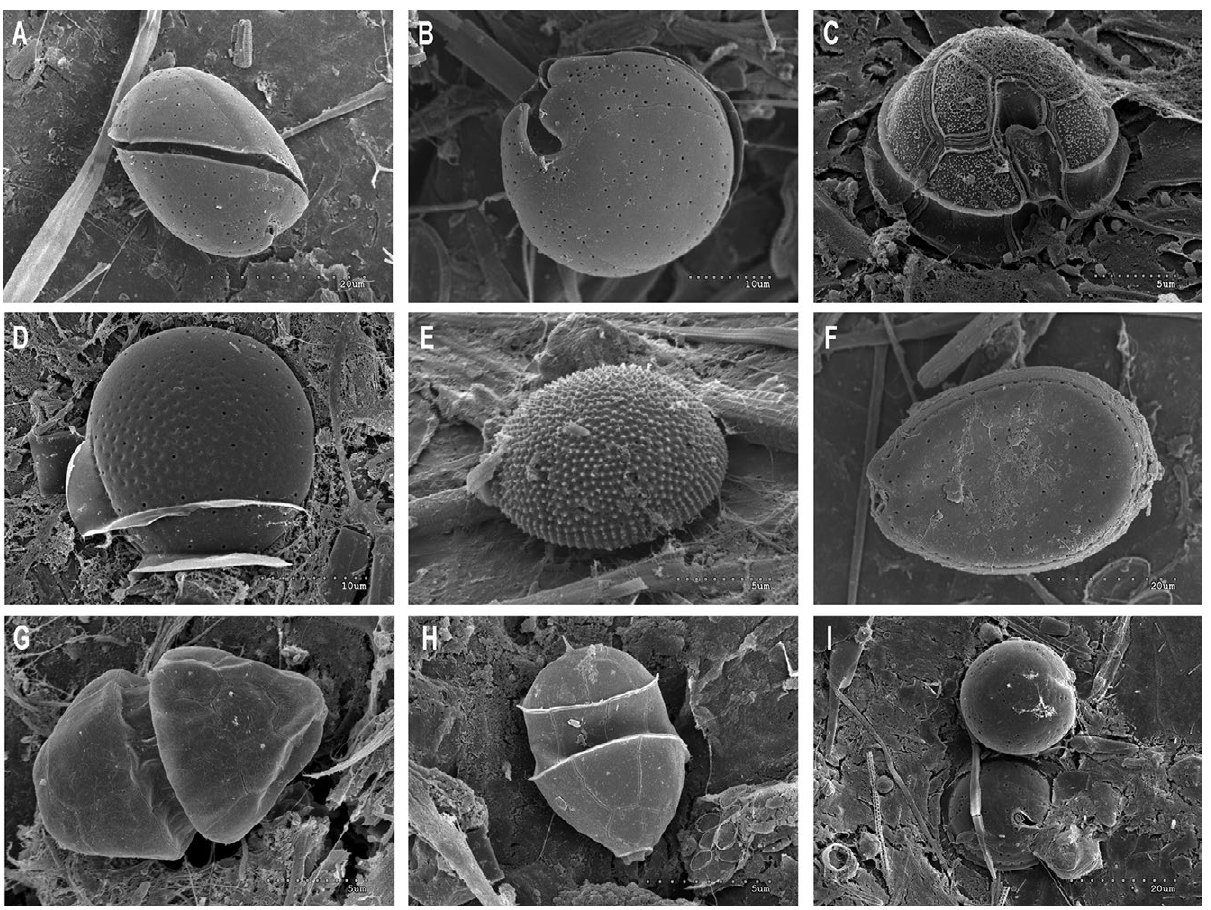
Fig. 3. – Dinoflagellates on pelagic plastics. A, B, Coolia sp.; C, Pentapharsodinium tirrenicum ; D, Dinophysis sp.; E, Prorocentrum mini- mum ; F, Prorocentrum lima ; G, H, Heterocapsa sp.; I, Unidentified dinoflagellate. Table 2. – Frequency of occurrence (%) of diatom genera identified on pelagic and benthic marine plastic debris (MPD). Third column, genera identified previously attached to plastic debris; a, Reisser et al. 2014; b; Zettler et al. 2013; c, Carpenter and Smith 1972. Pelagic MPD Diatom genera n=